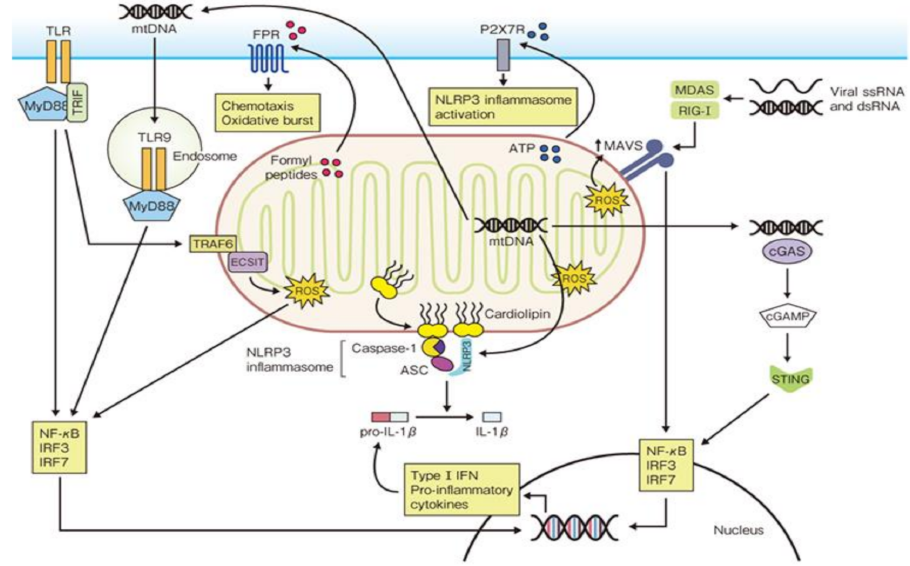
Figure 2. Mitochondrial regulation of innate immune